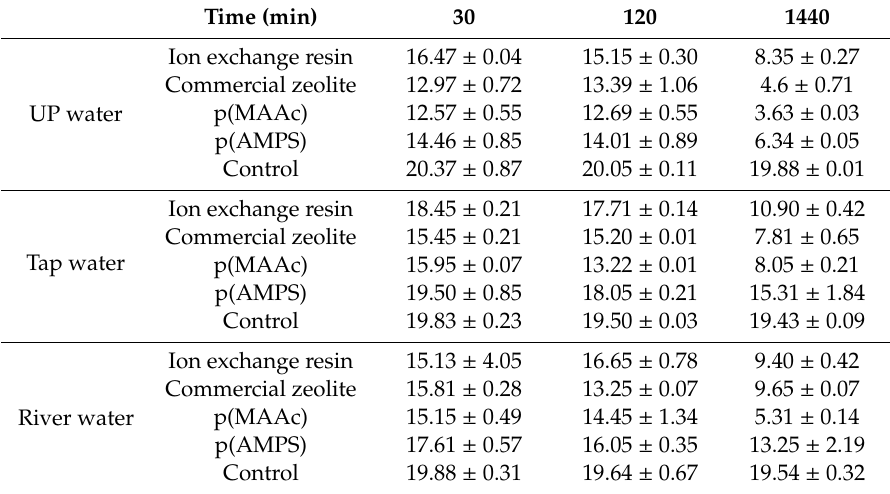
Table 5. Residual concentrations of Cd 2 + (mg / L) in various water matrices after adsorption.